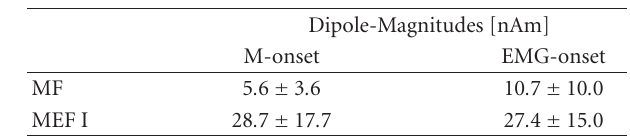
Table 1: Mean dipole magnitudes across the subject’s motor fields (MF) and Motor evoked fields I (MEF I) in movement onset (M- onset) and EMG-onset per wrist flexion and extension (mean ± standard deviation).